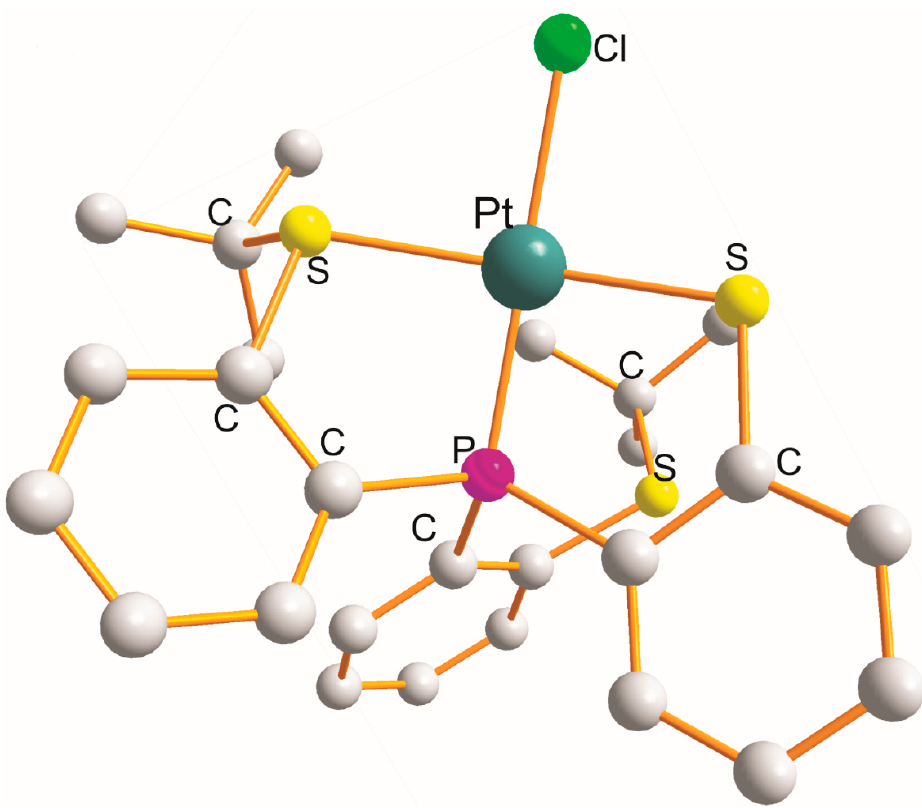
Figure 3. Structure of [Pt{ κ 3 –Pr i S 1 (C 6 H 4 )P 1 (C 6 H 4 SPr i )(C 6 H 4 )S 2 }(Cl)] [26].